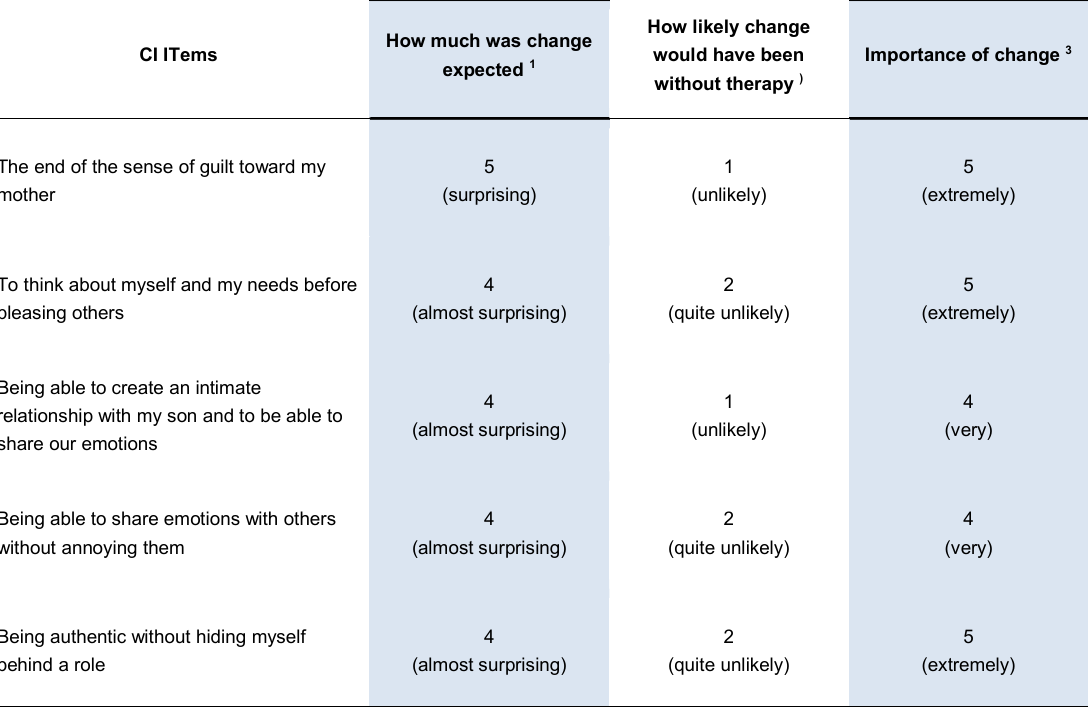
Table 5: Sara’s Changes identified In the Change Interview (Elliott et al. 2001). 1 The rating is on a scale from 1 to 5; 1= expected, 3= neither, 5= surprising. 2 The rating is on a scale from 1 to 5; 1=unlikely, 3=neither, 5=likely. 3 The rating is on a scale from 1 to 5; 1=slightly, 3 = moderately,